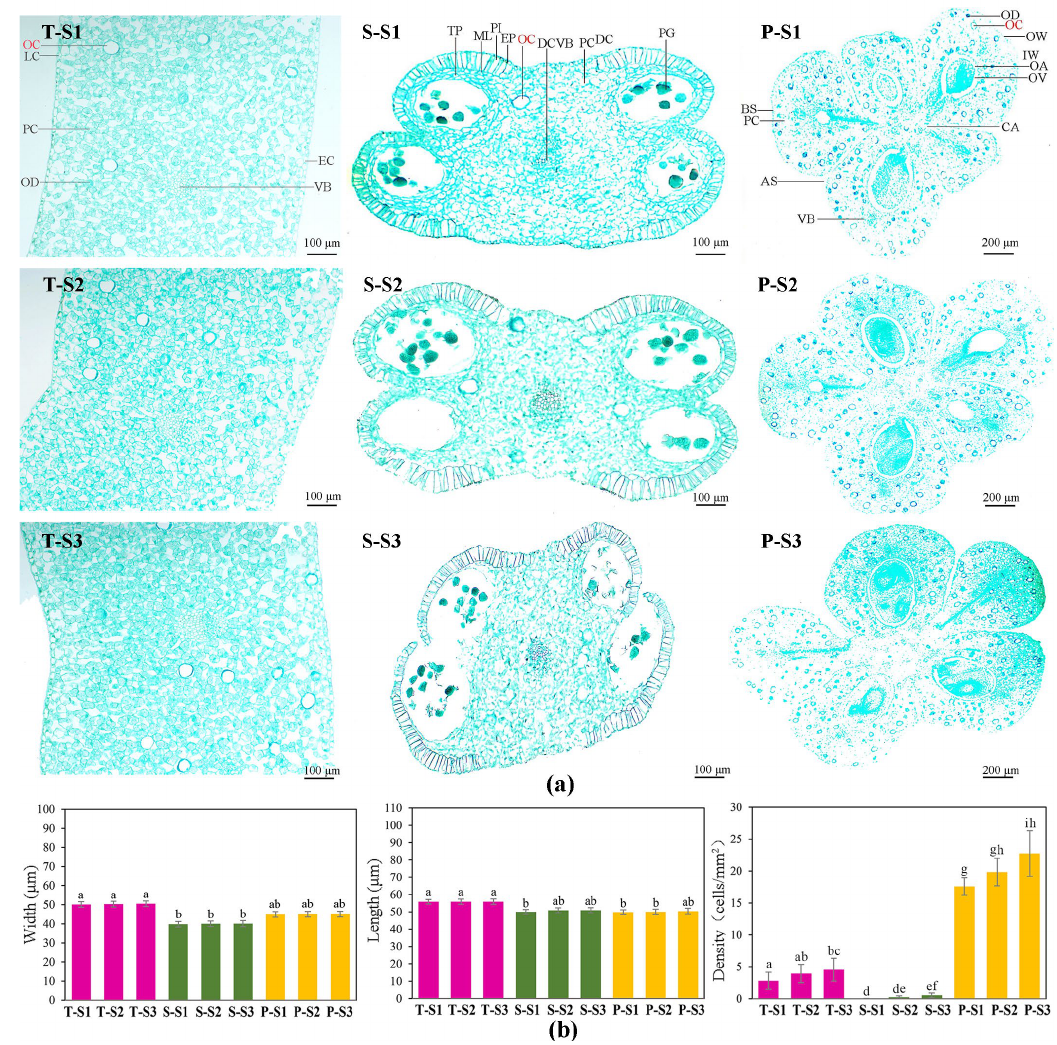
Figure 4. Cross-sections of M. crassipes flower organs ( a ) and comparison of their oil cells ( b ) at three flowering stages. Values are mean ± SD of three replicates. Different letters indicate a significant difference ( p < 0.05). (T: tepals; S: stamens; P: pistil; S1: bud stage; S2: initial flowering stage; S3: full flowering stage; EP: epidermis; DCVB: drug compartment vascular bundle; PI: pharmacy interior; ML: middle layer; TP: tapetum; FL: fiber layer; PG: pollen grains; PC: parenchyma cells; OC: oil cells; OD: oil droplets; DC: drug compartment).